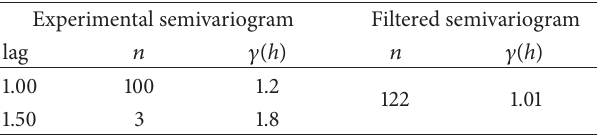
Figure 9: Experimental semivariogram filtering procedure. Table 1: Comparison between experimental and filtered semivari- ograms